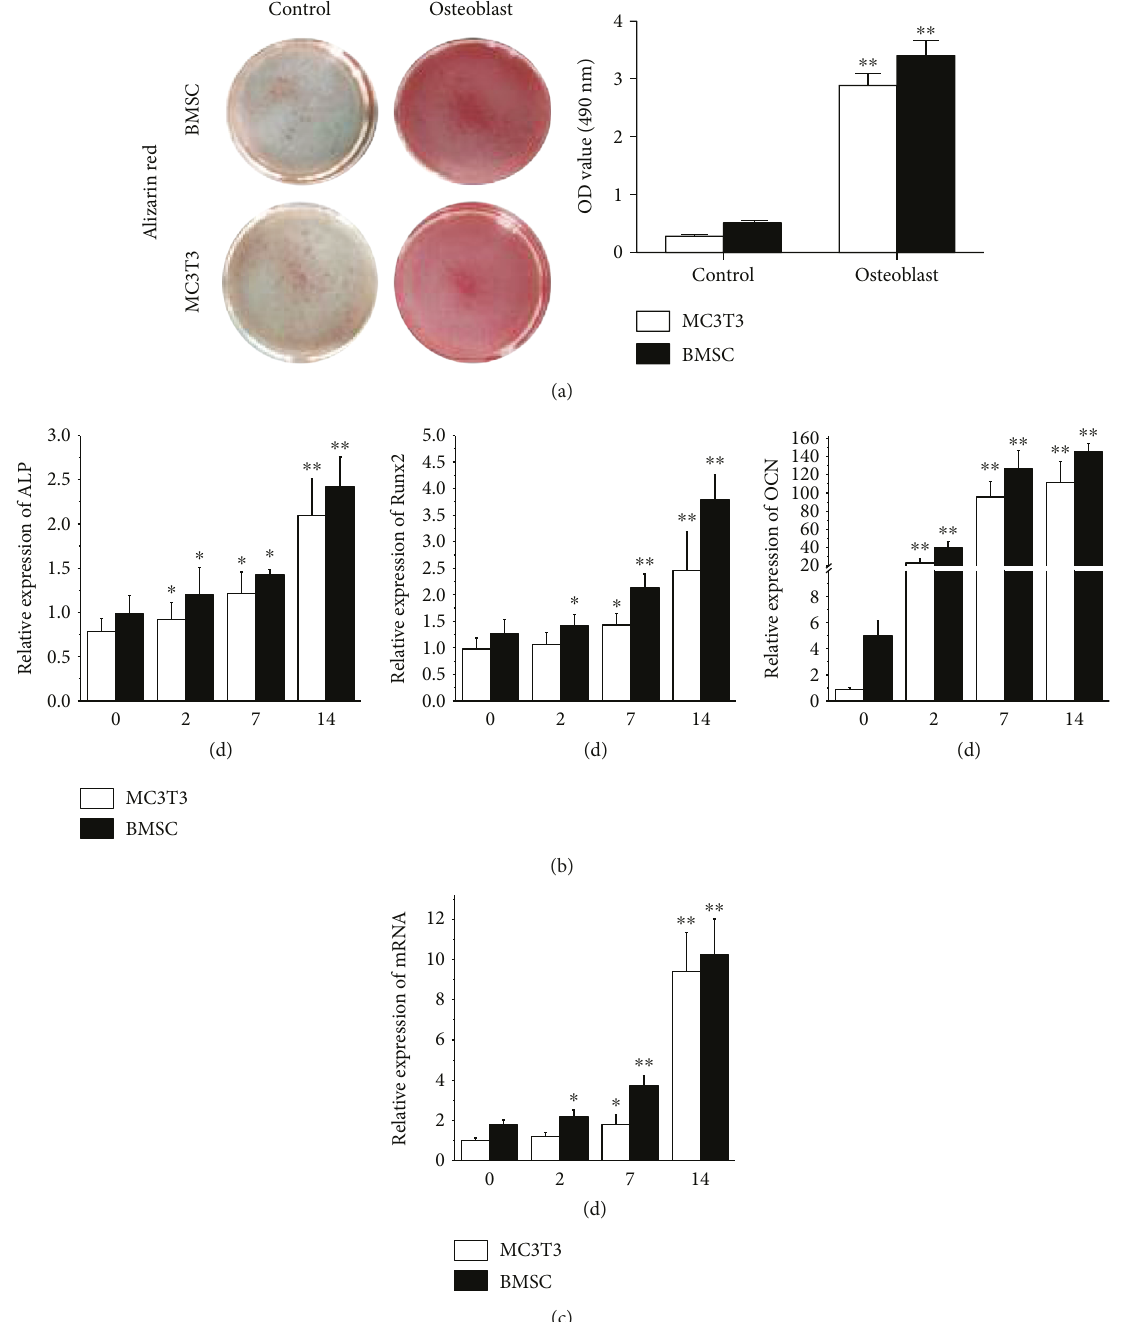
Figure 2: MiR-378 expression with osteoblast di ff erentiation in hBMMSCs and MC3T3 cells. (a) Alizarin red staining was performed at day 14. (b) Osteoblast relative gene was detected by qRT-PCR after 2-day, 7-day, and 14-day osteoblast induction. (c) miR-378 expression was signi fi cantly induced during di ff erentiation in hBMMSCs and MC3T3 cells. ∗ P < 0 05 and ∗∗ P < 0 01 ; n = 3